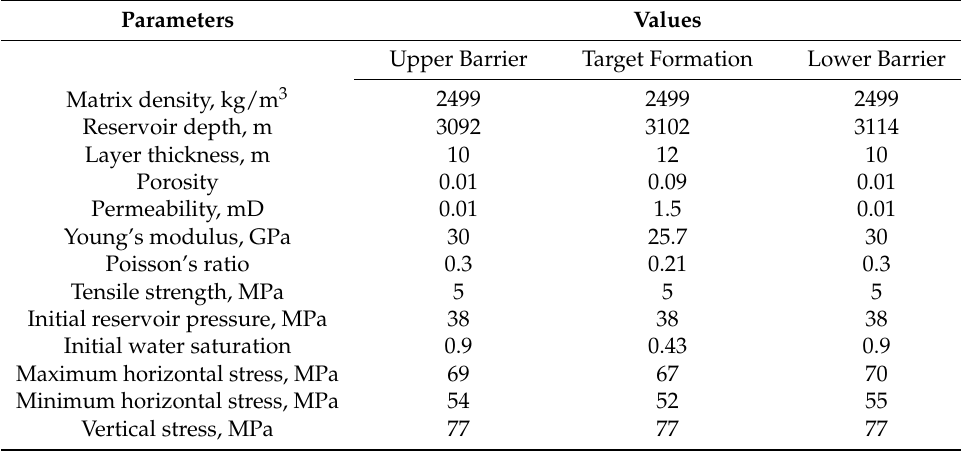
Figure 7. Construction of the base model for numerical simulations: ( a ) top view; ( b ) 3D view. Table 1. Base case formation parameters in the numerical simulations.